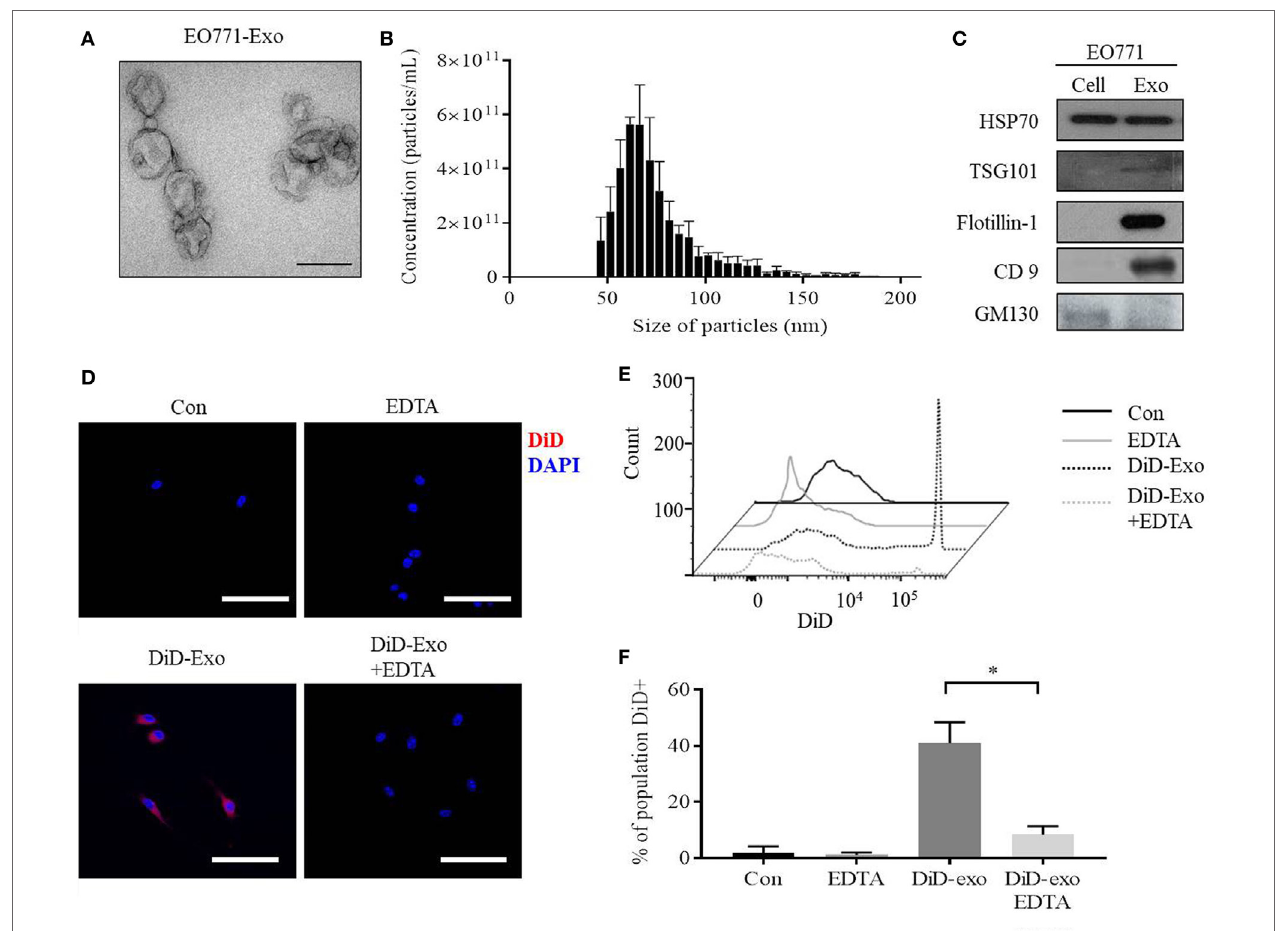
FigUre 1 | EO771 cells secrete exosomes which are taken up by bone marrow-derived macrophages (BMDMs). (a) Transmission electron microscopy of isolated particles indicates a sphere-shaped structure. The size bar represents 100 nm. (B) Size distribution and enumeration of particles assessed by Tunable Resistive Pulse Sensing ( n = 3). (c) Expression of exosomal and cell markers in EO771 cell lysate (Cell) and exosomes (Exo). (D) Immunofluorescence imaging of DiD-labeled, EO771-derived exosome uptake into macrophages after 24 h. Macrophages were pretreated with EDTA (1 µM) for an hour as indicated. The size bar represents 50 µm. (e,F) BMDMs were gated for CD11b + /F4/80 + double-positive populations and DiD + cells quantified. (e) Representative histogram of flow cytometry analyses. (F) Quantification of four independent repeats. * p < 0.05 as